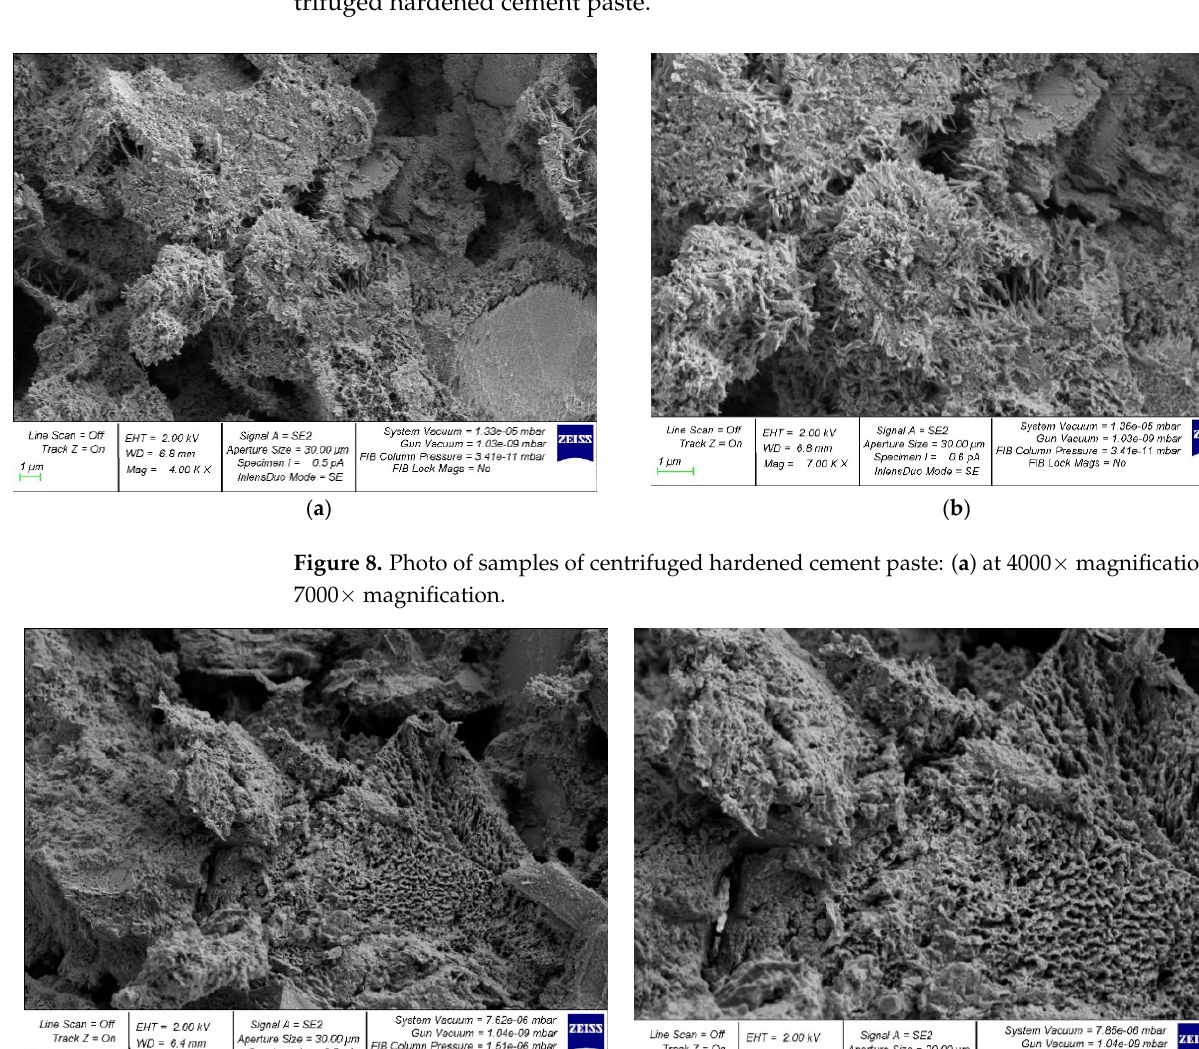
Figure 7. Change in tensile strength in bending by layers (C—centrifuged concrete, VC—vibrocen- trifuged concrete).